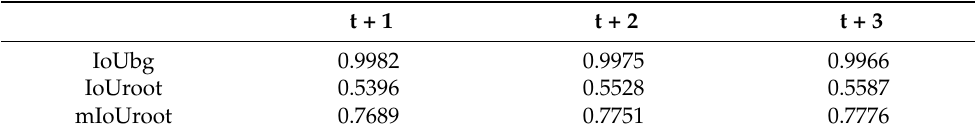
Table 3. Average IoU at each time step of root growth